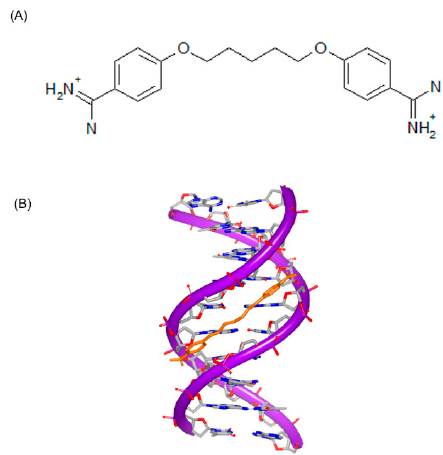
Figure 9. ( A ) Chemical structure of pentamidine; and ( B ) complex of DNA with pentamidine (PDB code: 3EY0). The orange structure represents the small molecule; the purple structure represents the backbone of nucleic acid; the blue and red atoms in the molecule represent nitrogen and oxygen atoms, respectively.